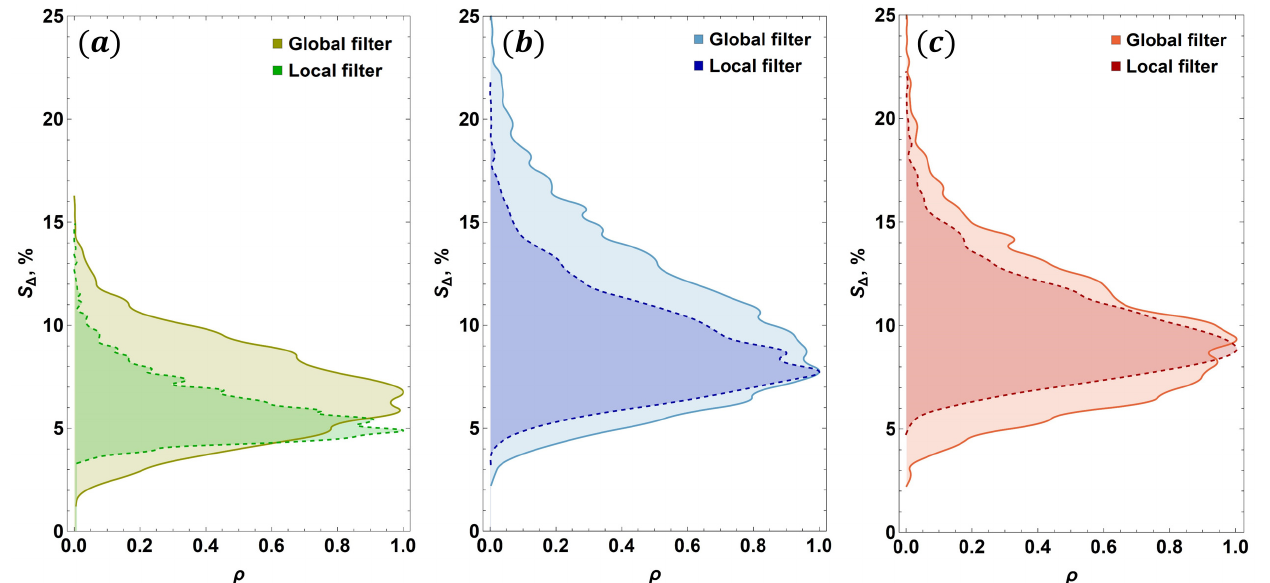
Figure 24. Static reference body: smooth normalized S ∆ histograms for neutron flux transmission along the ( a ) smaller (20 mm) axis, ( b ) larger (30 mm) axis and ( c ) larger axis with an extra 1 cm distance between the scintillator and the body (0 mm by default). Note the color legends in the upper right corners of ( a – c ) indicating results for the global and local filters. Here ρ is the normalized event density. Histogram bins were determined using the Scott method and 2-order interpolation was applied to bin density values.